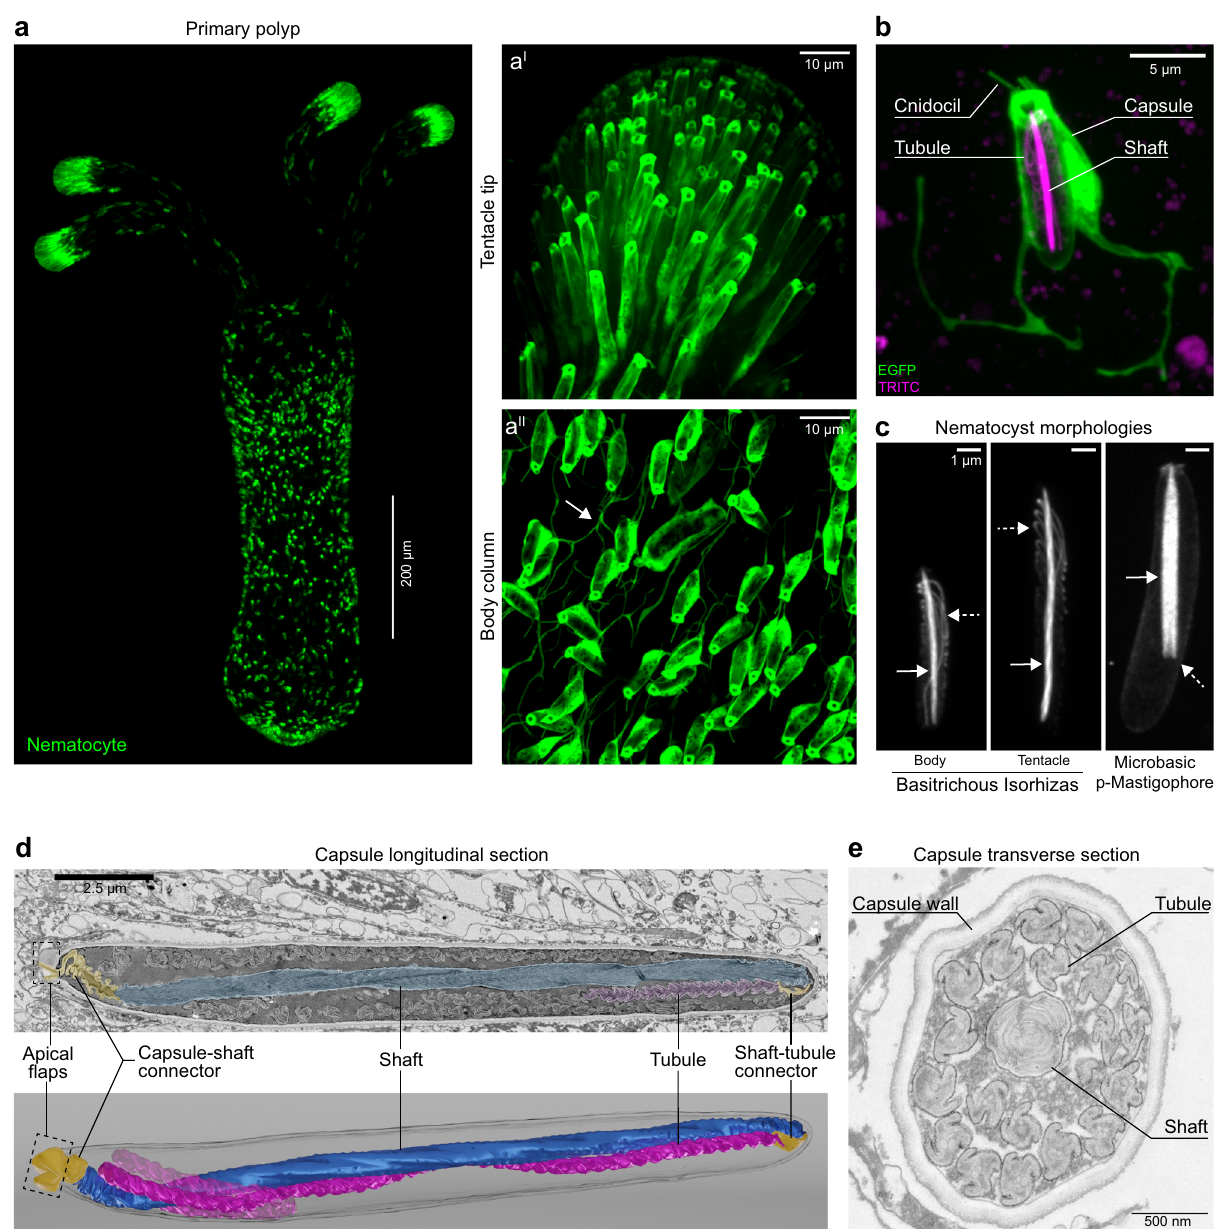
Fig. 1 The architecture of undischarged nematocysts. a Nematocytes ( green ) of a transgenic N. vectensis primary polyp expressing EGFP under the control of the nematogalectin promoter a I EGFP expression at the tentacle tip. a II EGFP expression on the body column. The arrow points to the network of cellular processes connecting nematocytes. The images are representative of primary polyps tentacles and body columns from 6 spawns. b Close-up view of a single nematocyte on the body column of a primary polyp expressing EGFP in nematocytes (green). The cnidocil (sensor) apparatus, cell body, and neurite- like processes are shown. TRITC (magenta) labels the capsule, the centrally positioned shaft, and the folds of the tubule ( n = 10 primary polyp body columns, fi ve experiments). c Nematocyst morphologies in N. vectensis based on the fl uorescence signal of incorporated TRITC. Basitrichous isorhizas capsules ( n = 19 short, n = 20 long) with densely labeled shaft (arrow) and coiled tubule (dashed arrow) continuous with the compressed shaft (left and middle panels). Microbasic p-mastigophores capsules( n = 10) shaft (arrow) with its distinctive V-shaped notch (right panel, dashed arrow) Images representative of puri fi ed nematocysts from ~300 primary polyps). Scale bars 1 μ m. d Longitudinal section of a nematocyst showing densely coiled shaft fi laments (blue), a portion of the coiled tubule (magenta), and the two connector regions, the capsule-shaft connector and shaft-tubule connector (yellow). The apical fl aps are seen in a partially open conformation (dashed box). Corresponding 3D reconstruction of the longitudinal section shows the capsule, central shaft (blue), a portion of the attached tubule (magenta), connector regions (yellow), and apical fl aps (dashed box). e Transverse section of a nematocyst showing the capsule wall, dense lamellar shaft, and the propeller shaped tubule. ( n = 2 complete volume capsules images from ∼ 350 capsules visible in 2 primary polyp